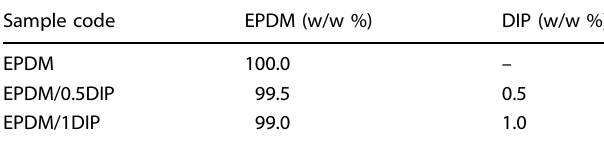
Table 2. Components of the studied EPDM and EPDM/DIP